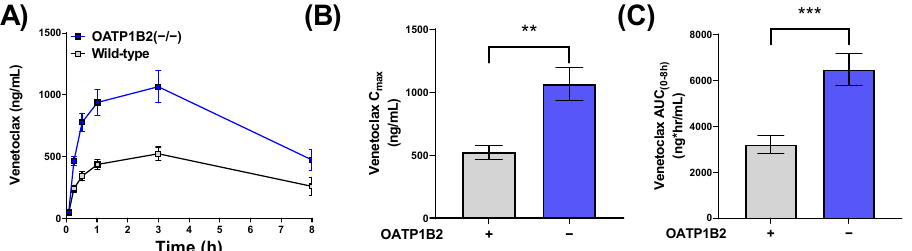
Figure 3. The genetic deletion of OATP1B2 increases venetoclax exposure. ( A ) Plasma concentration curves of venetoclax in female wild-type DBA or OATP1B2( − / − ) mice administered venetoclax (10 mg/kg; PO) ( n = 10/group). Serial plasma samples were collected from each mouse and analyzed via LC-MS/MS. ( B ) Maximum concentration (C max ) and ( C ) area under the concentration-time curve (AUC) using the last observed timepoint (AUC 0–8h ) calculated with non-compartmental analysis (NCA) using Phoenix WinNonlin 8.1., ** p < 0.01, *** p < 0.001.